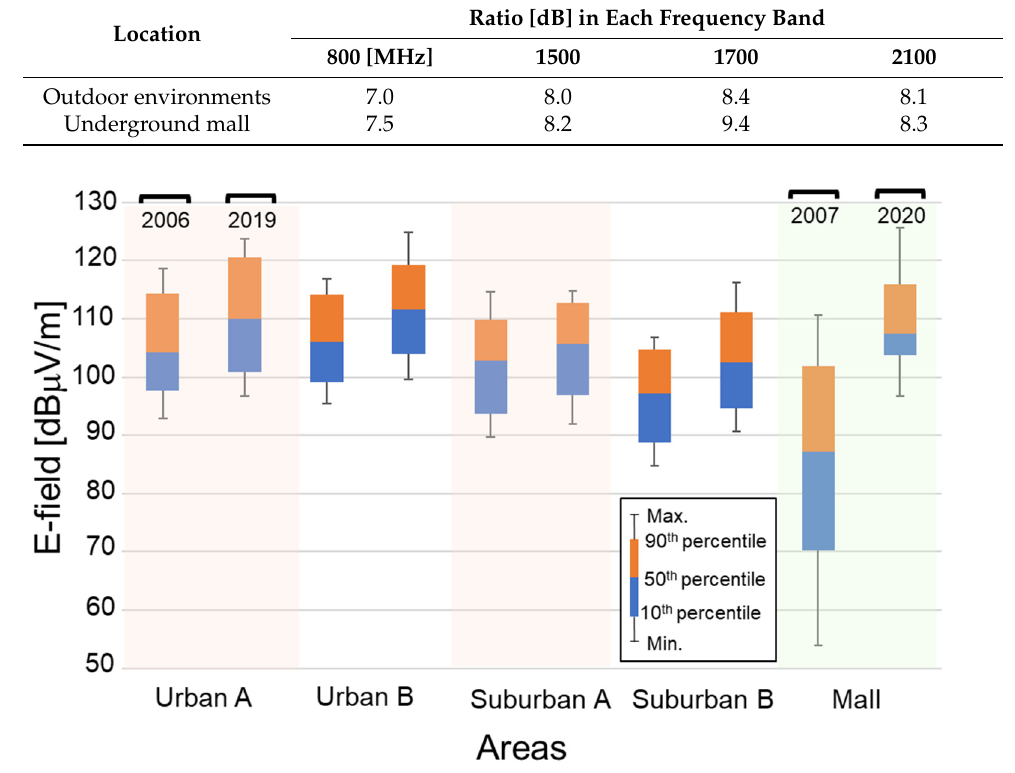
Figure 5. E-field strength distributions in all frequency bands.